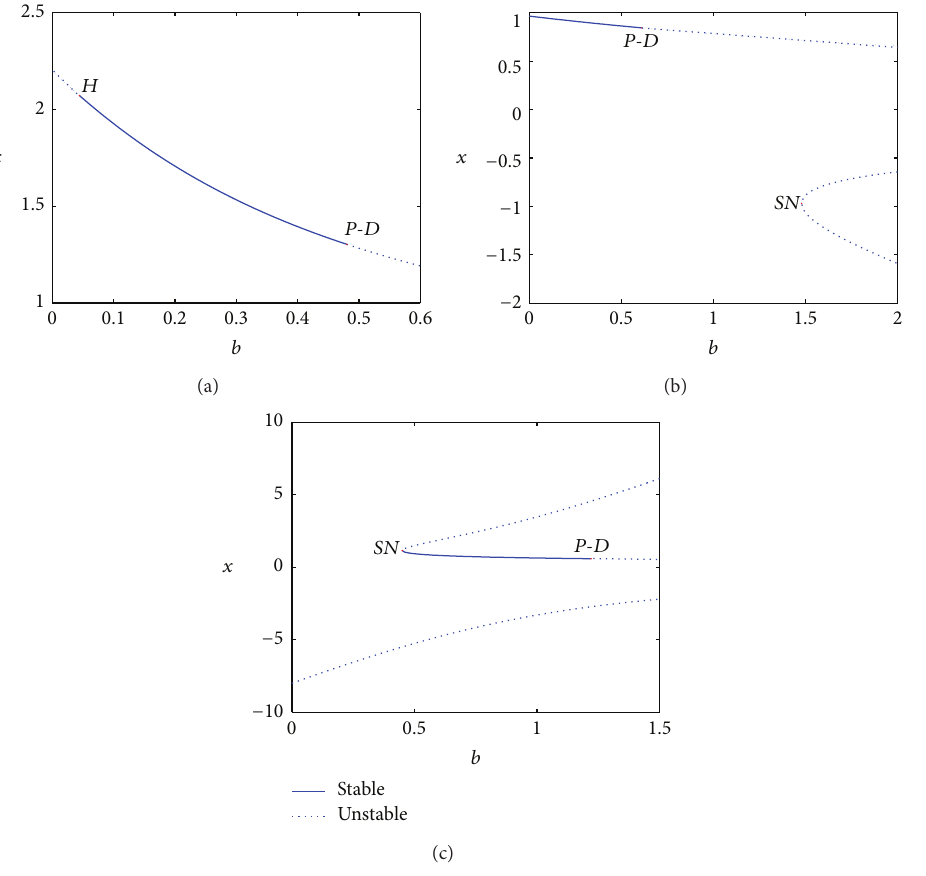
Figure 3: Bifurcation diagrams of the fixed points of map (2) in (𝑏,𝑥) plane for (a) 𝑎 = 0.7 , 𝑐 = 0.3 , 𝑑 = −0.15 , and 𝑒 = 0.08 ; (b) 𝑎 = 0.5 , 𝑐 = −0.1 , 𝑑 = −0.04 , and 𝑒 = 0.7 ; (c) 𝑎 = −0.5 , 𝑐 = 0.8 , 𝑑 = 0.1 , and 𝑒 = 0.1 .